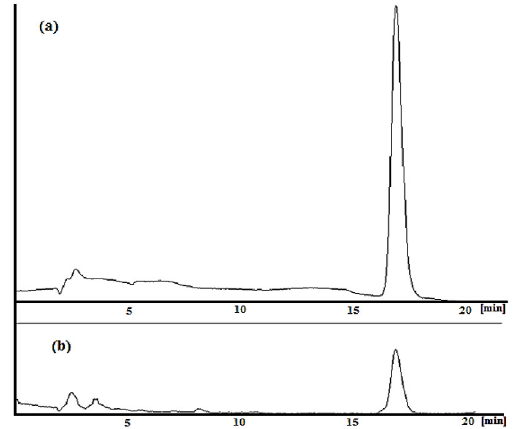
Fig. 6. SEM image of the loaded PX particles in the aerogel structure in DMSO/water ratio of 6 (v/v), ethanol concentration of 7.5%, the pressure of 20 MPa, the temperature of 50 ºC and flow rate of 3 mL/min. CO 2